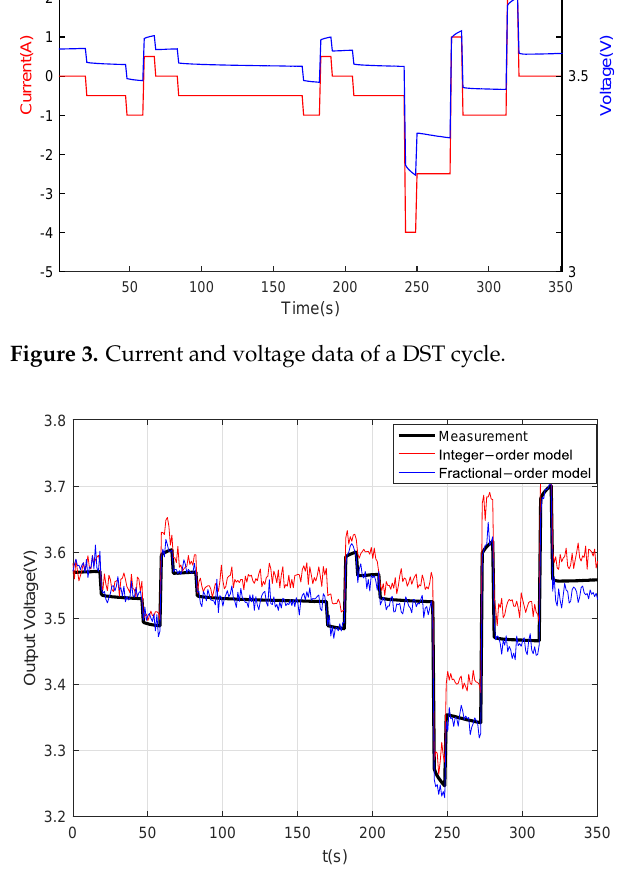
Figure 4. Accuracy verification of the model.